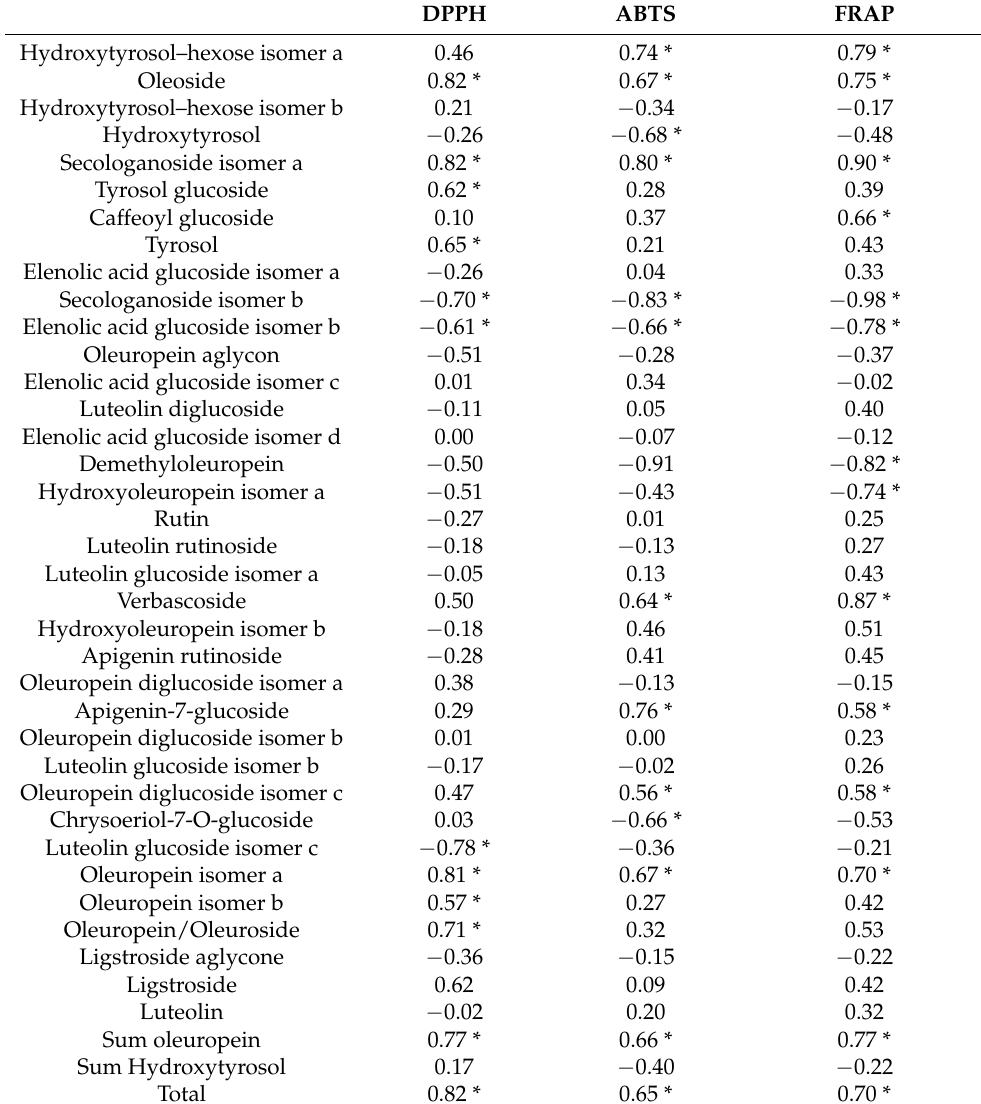
Table 6. Correlation analysis of phenolic content and antioxidant activities of olive leaves extract. Different letters corresponding to the number of